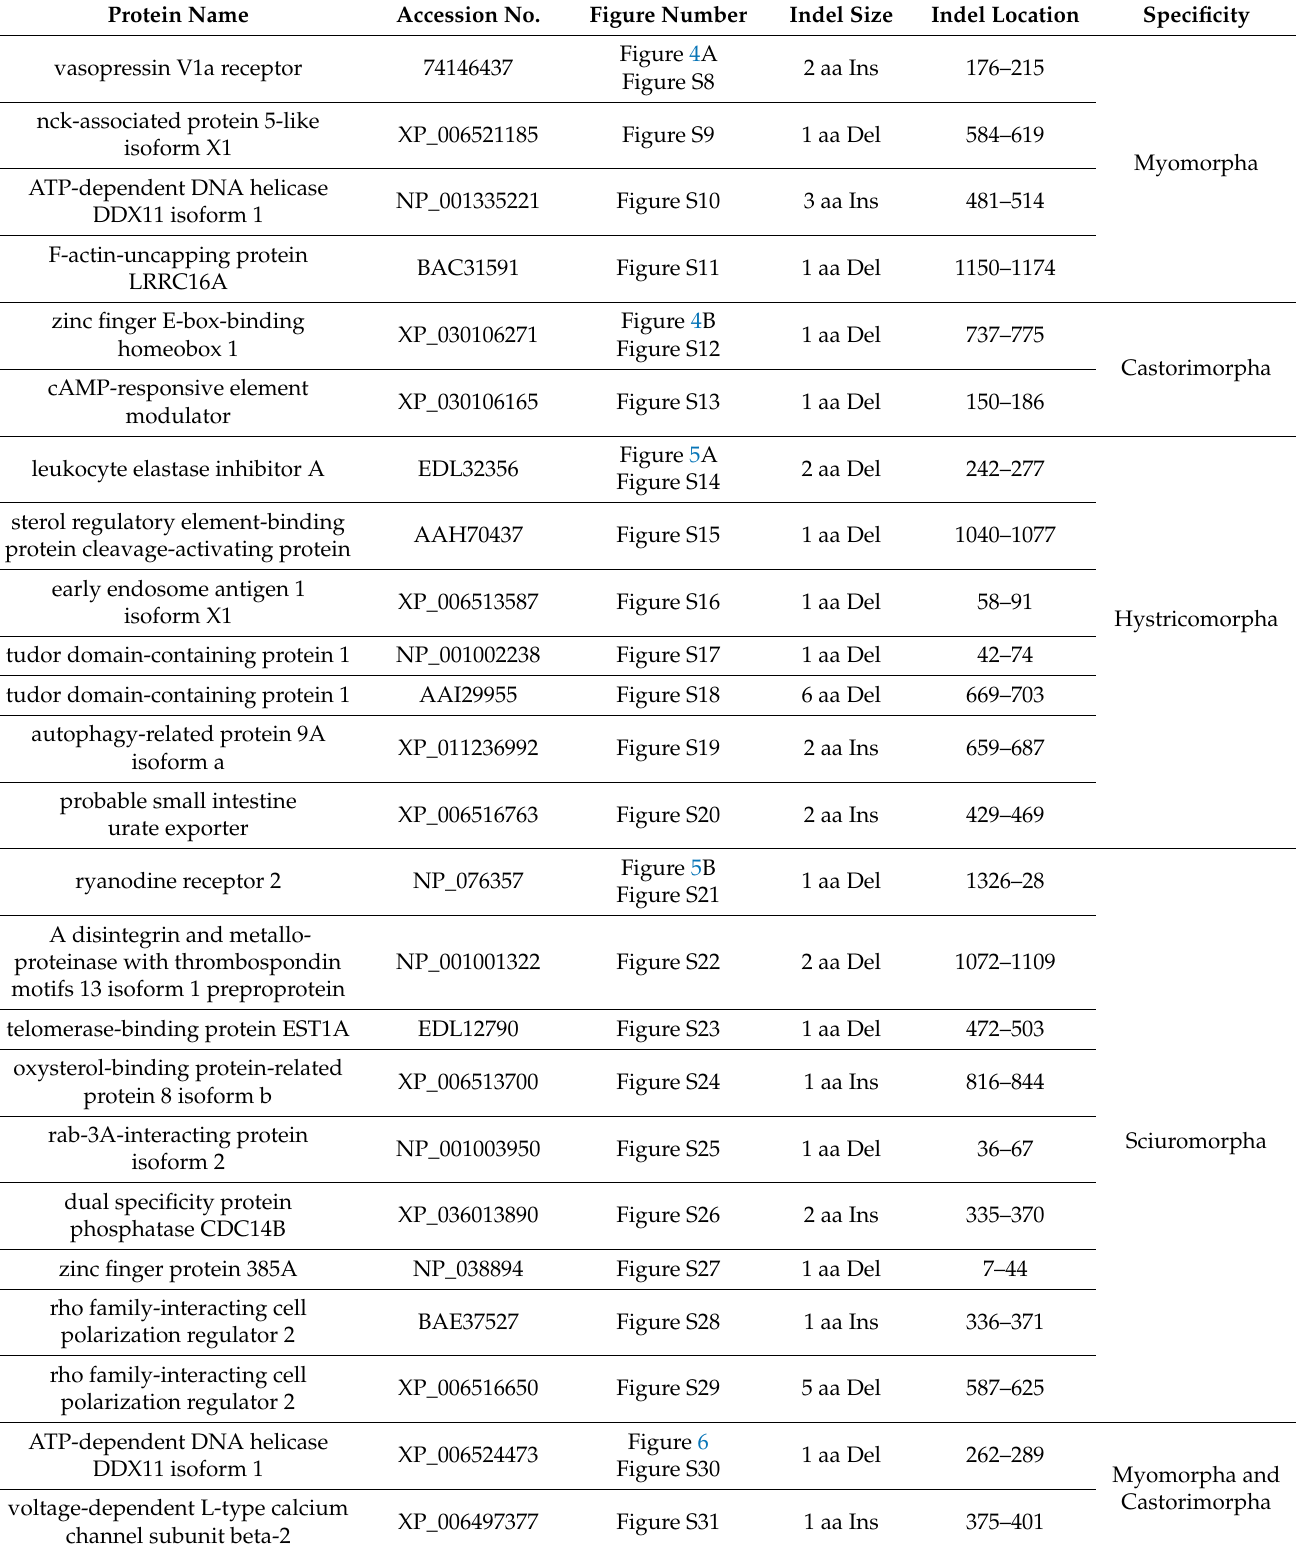
Table 2. Characteristics of the CSIs specific for different suborders of